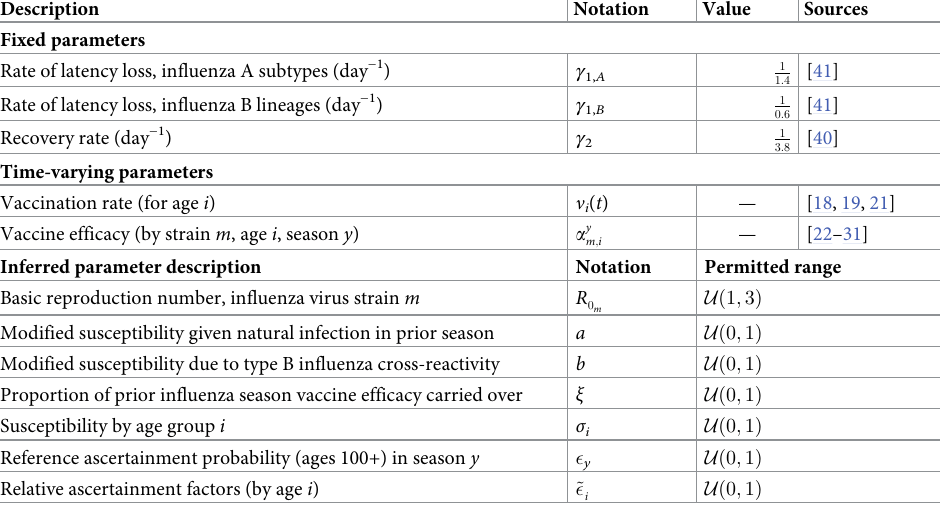
Table 2. Overview of model